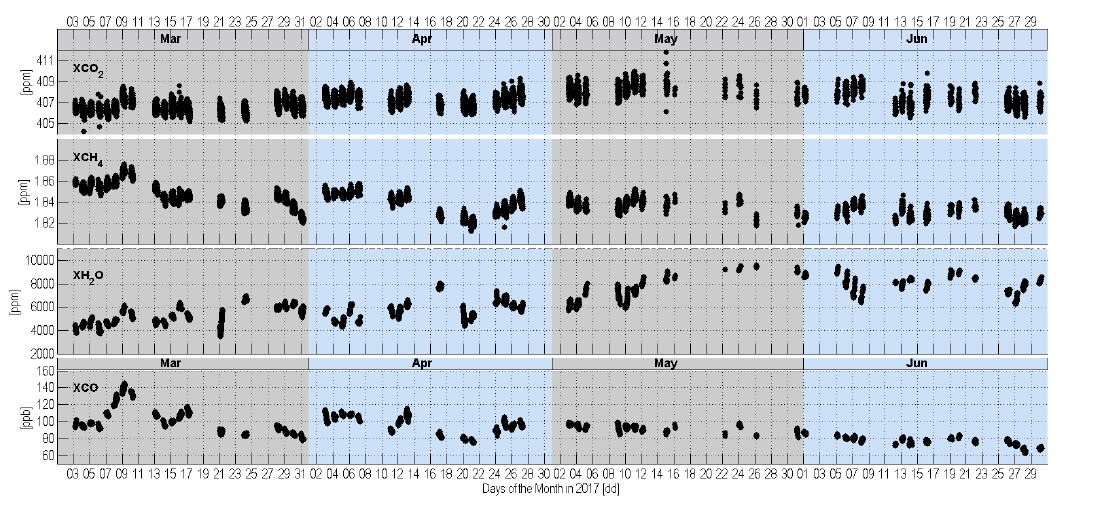
Figure 1. Retrieved column-averaged dry air mole fractions of CO 2 , CH 4 , H 2 O and X CO from the TCCON station in Burgos, Ilocos Norte,